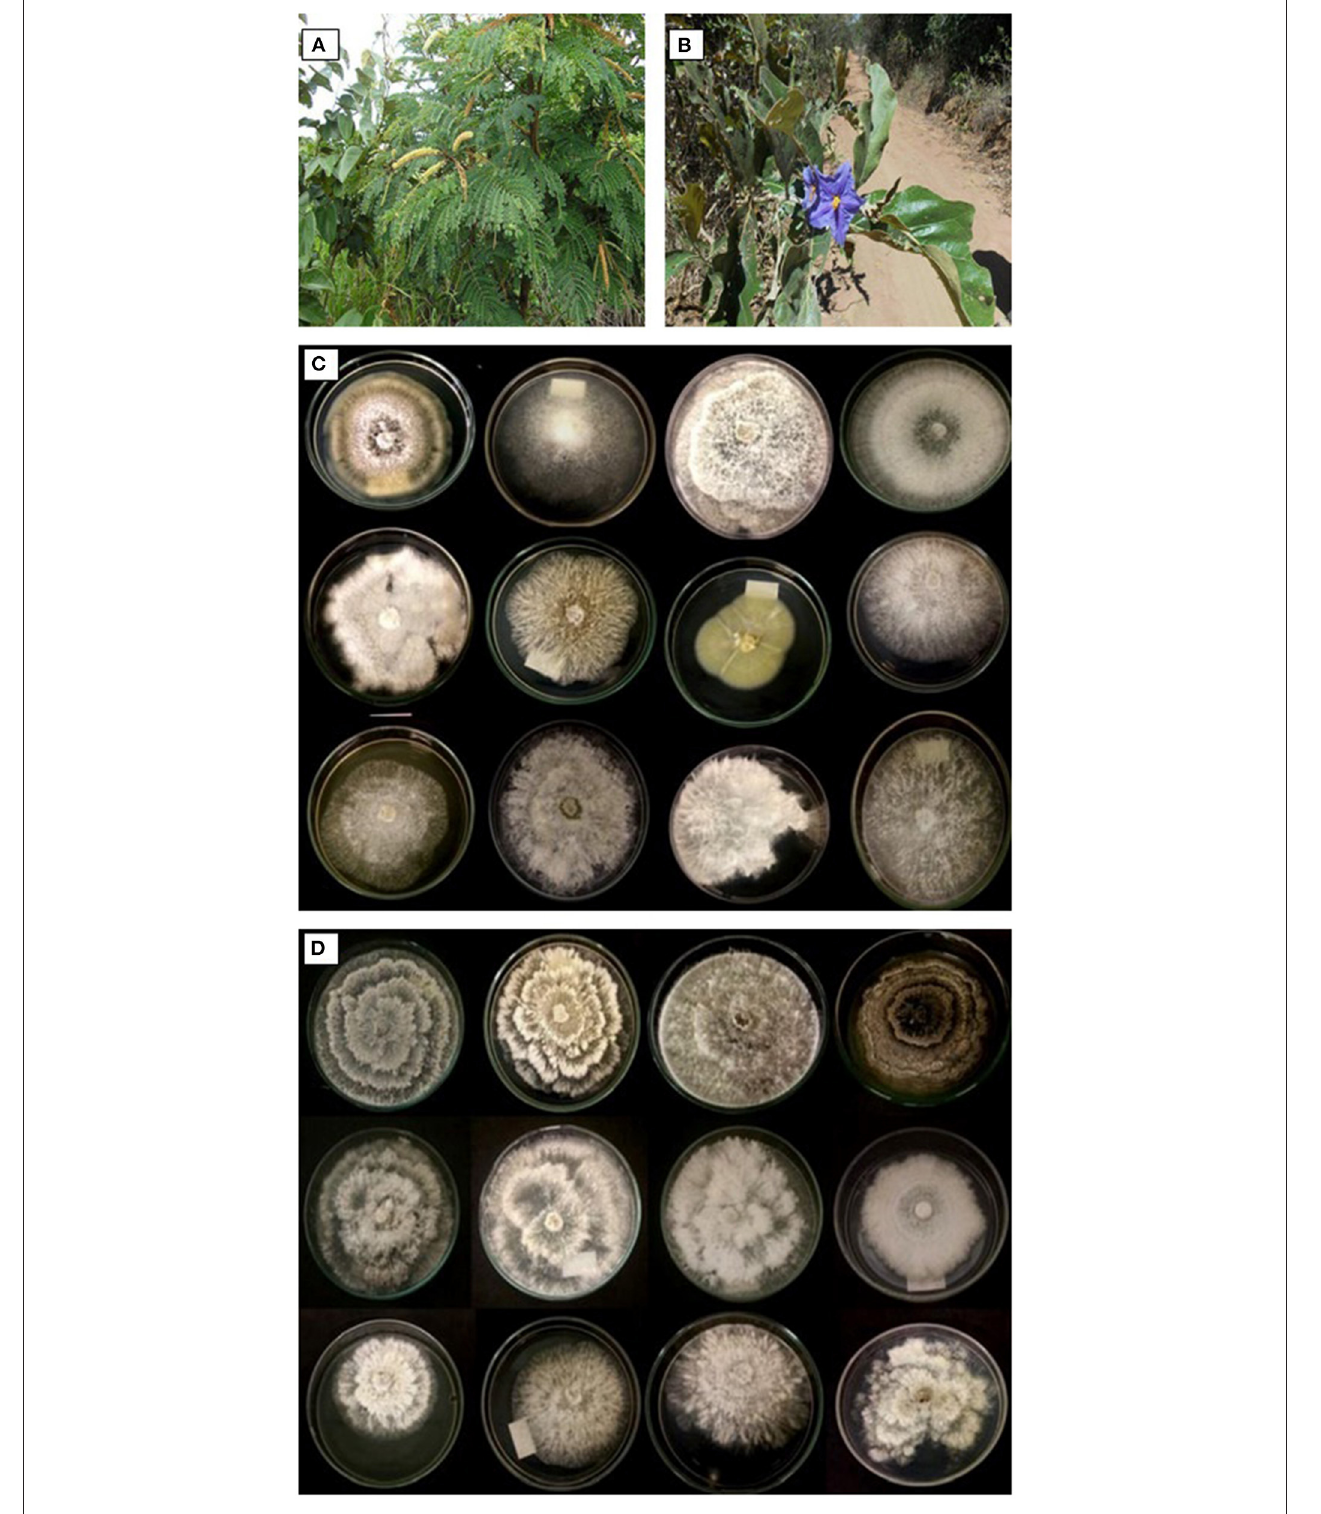
FIGURE 2 | Examples of endemic Brazilian tropical savannah trees (22 ◦ 01 ′ 03 ′′ S, 47 ◦ 53 ′ 27 ′′ W). (A) Stryphnodendron adstringens (Mart.) Coville (Fabaceae); (B) Solanum lycocarpum Saint-Hill (Solanaceae). Fungal morphological groups retrieved in the culture media isolation procedure. Endophytic fungi (morphological groups) isolated from leaves of S. adstringens (C) and S. lycocarpum (D) .